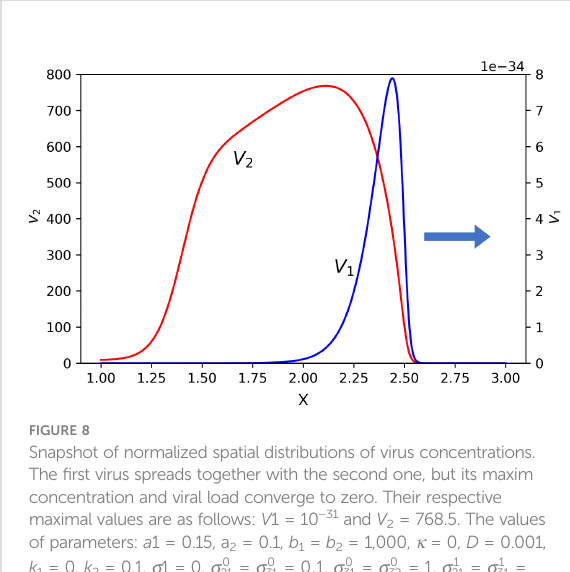
FIGURE 8 Snapshot of normalized spatial distributions of virus concentrations. The fi rst virus spreads together with the second one, but its maxim concentration and viral load converge to zero. Their respective maximal values are as follows: V 1 = 10 − 31 and V 2 = 768.5. The values of parameters: a 1 = 0.15, a 2 = 0.1, b 1 = b 2 = 1,000, k = 0, D = 0.001, k k s 1 = 0, s 0 s 0 : 1, s 0 s 0 s 1 s 1 1 = 0, 2 = 0.1, 31 = 21 = 31 = 0 31 = 32 = 1, 21 = 0 : 1, s 1 21 = s 1 32 = 0, s 4 =